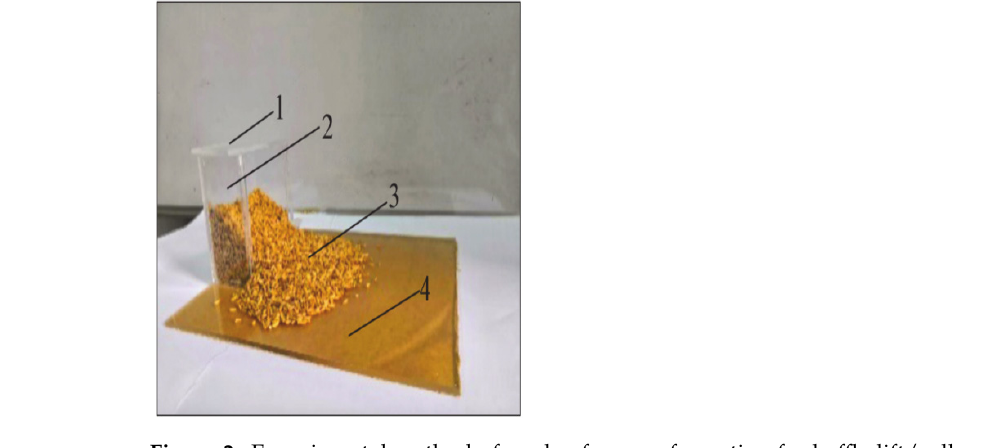
Figure 2. Experimental method of angle of repose formation for baffle lift/collapse method [60]. 1. Side wall; 2. Shell; 3. Oat seeds; 4 Plexiglass plate.